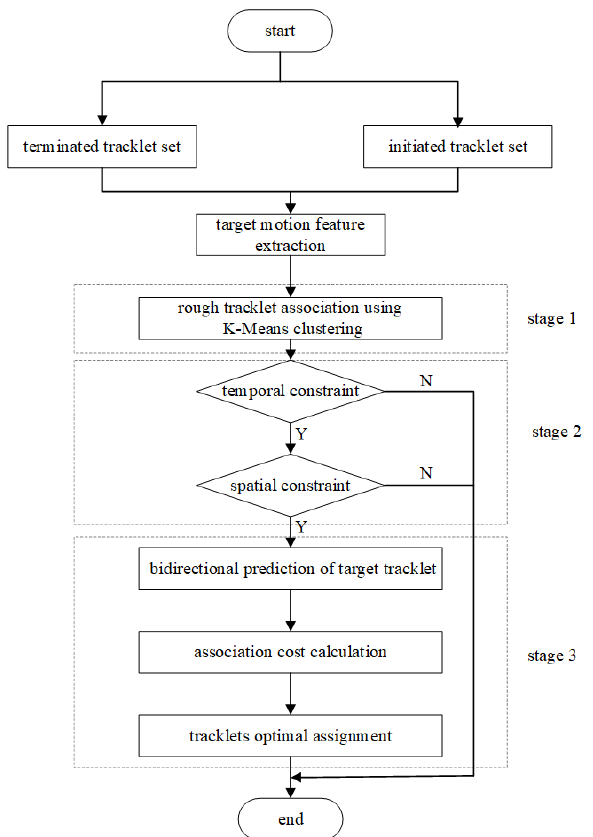
Figure 3. The flowchart of the multi-stage tracklet association method.